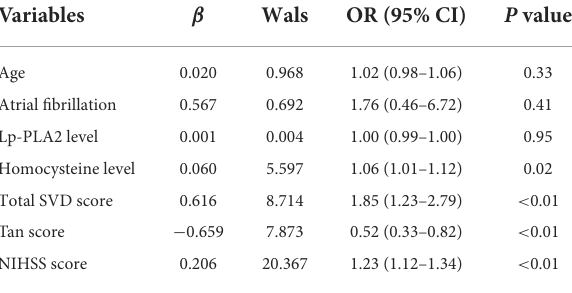
with multiple CMBs have a six times higher risk of recurrent stroke than those without CMBs and exhibit an increased fatality rate of stroke (31). A population-based cohort study reported that an increase in the mean carotid intima-media thickness, a marker of LAA, was related to an increased risk of CMBs, especially in the deep and infratentorial brain regions (8). EPVS and lacunes may also be related to the prognosis of patients with LAA stroke, although our present study did not observe significant differences in these parameters. EPVS are strongly associated with age and may correlate with the functional outcome and prognosis of patients with LAA stroke. The pathological examination of EPVS revealed that the brain tissue surrounding the lesions was destroyed, accompanied